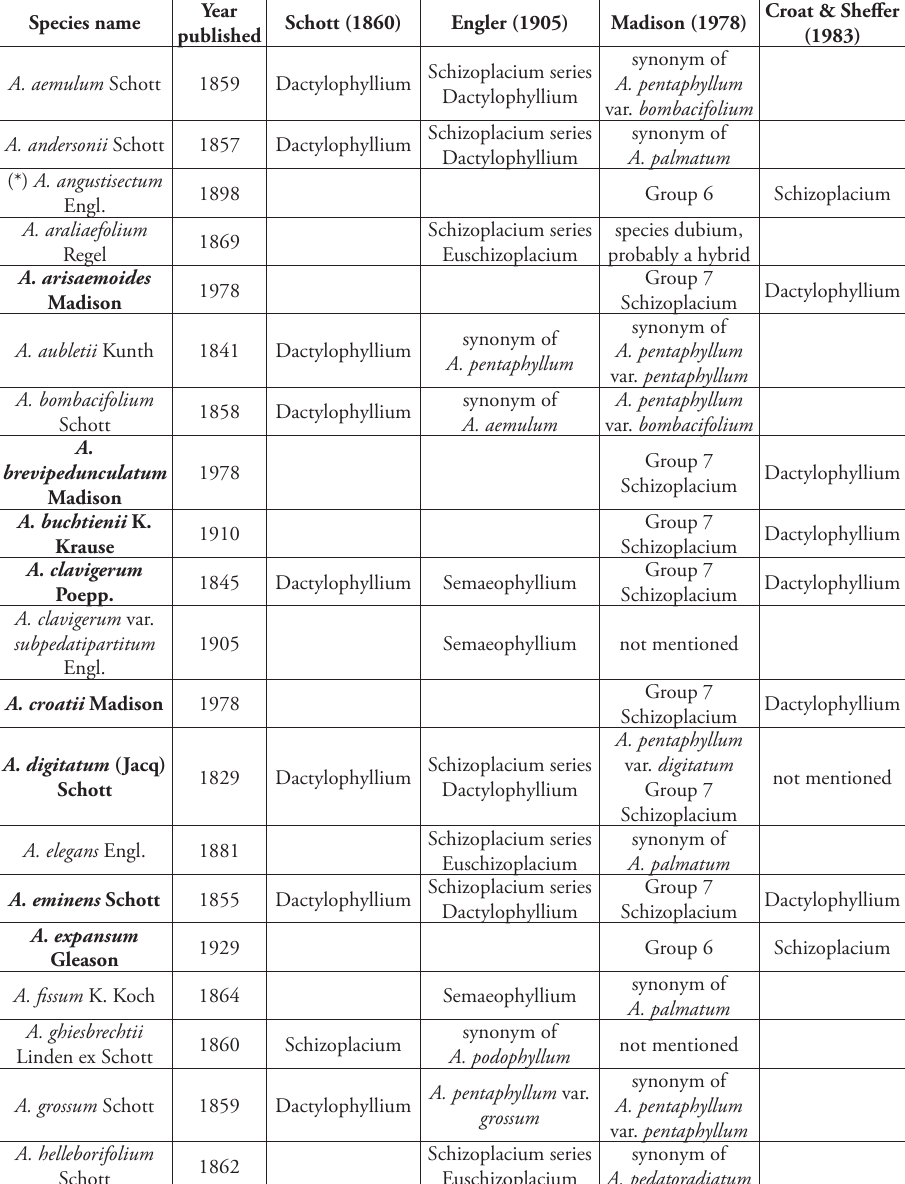
table 1. Anthurium species with palmately divided leaves formerly included in Dactylophyllium and Schizoplacium , a comparison of previous circumscriptions. This is not an exhaustive list of all species names that have been previously included in these groups, it only contains taxa that were accepted at the time of publication of each work. Names in bold denote species included in the newly redefined section Dactylophyllium (Schott) Engler emend. Croat & Carlsen, as proposed here. Species marked with (*) are now formally excluded from this emended section. All other species names are either synonyms or species dubia, fide Madison